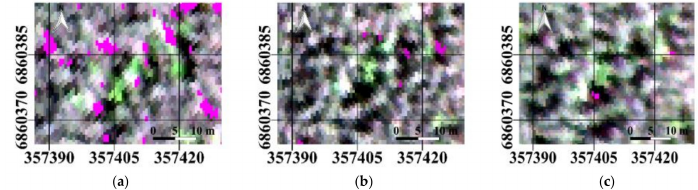
Figure 4. True color images of the focus area (red rectangle in Figure 2) inside the test polygon showing spatial variation in Scots pine canopy brightness for different scatter angles ( β = 19 ◦ ( a ); β = 55 ◦ ( b ); β = 76 ◦ ( c )). Purple pixels were masked out; normalized difference vegetation index (NDVI) <